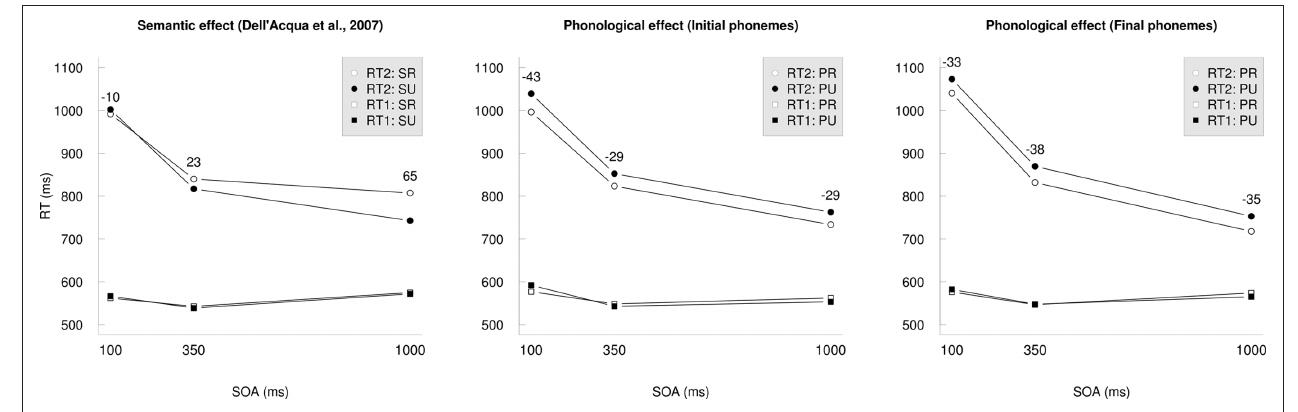
Figure 2 | Left panel: results of the semantically related manipulation reported in Dell’Acqua et al. (2007a) . Center Panel: Results for the begin- related phonological manipulation in Experiment 1. Mean reaction times, plotted separately for tone discrimination (RT1) and picture naming latencies (RT2), as a function of phonological relatedness, and SOA. PR = picture and word